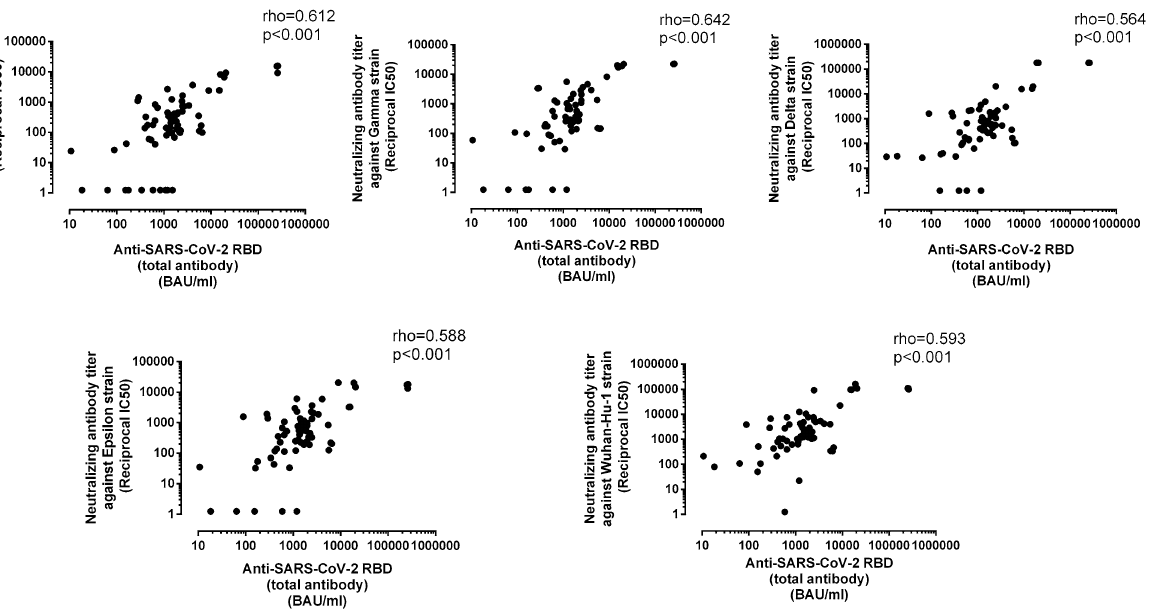
Figure 4. Overall correlation between neutralizing antibody titers and anti-SARS-CoV-2 RBD total antibody levels, as measured by the Roche Elecsys electrochemiluminescence sandwich immunoassays (Roche Diagnostics, Pleasanton, CA, USA), according to the SARS-CoV-2 S-variant. Rho and P values are